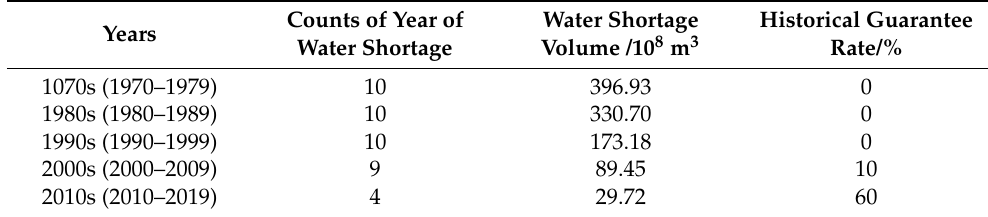
Table 5. Water shortage and guarantee rate in years.